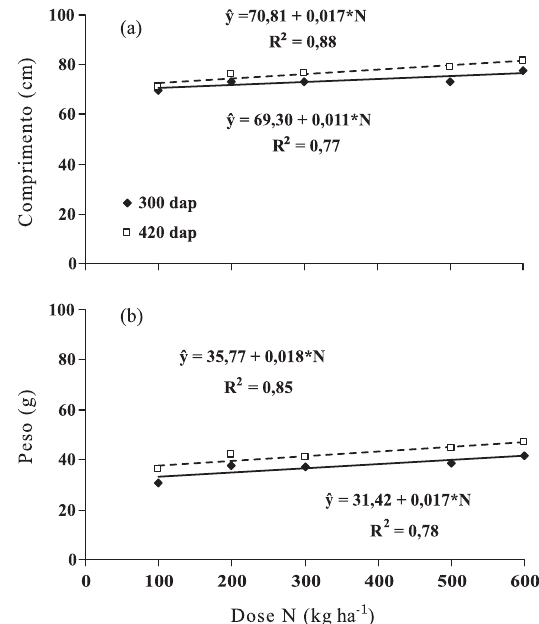
Figura 1. comprimento (a) e peso da folha ‘d’ (b) de abacaxizeiros ‘Vitória’, aos 300 e 420 dias após o plantio (dap), em função das doses de N. * significativo a 5 % pelo teste